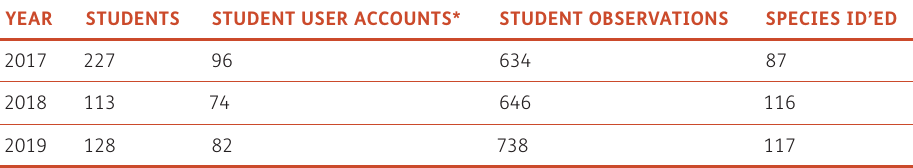
Table 3 iNaturalist project statistics for student